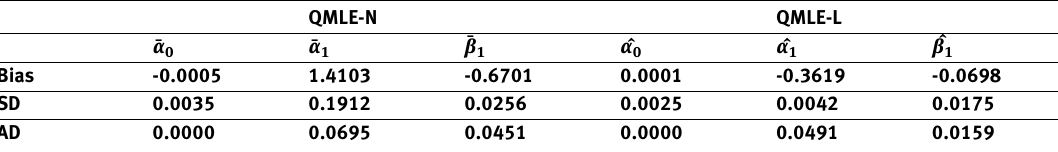
Table 3. Estimators for GARCH(1,